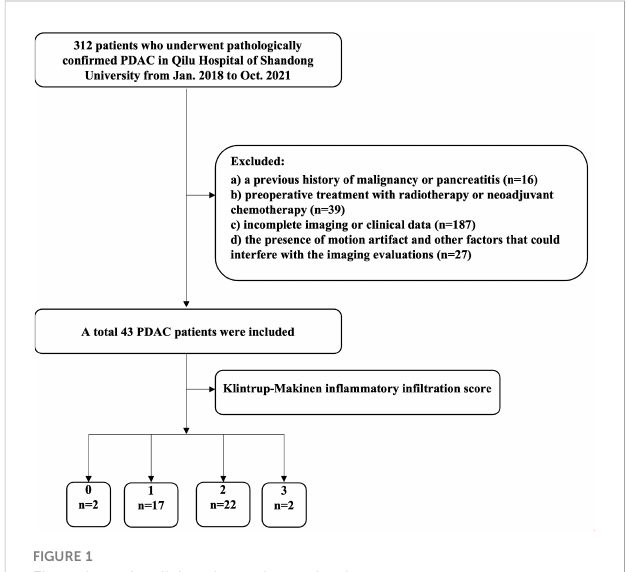
FIGURE 1 Flow chart visualizing the patient selection